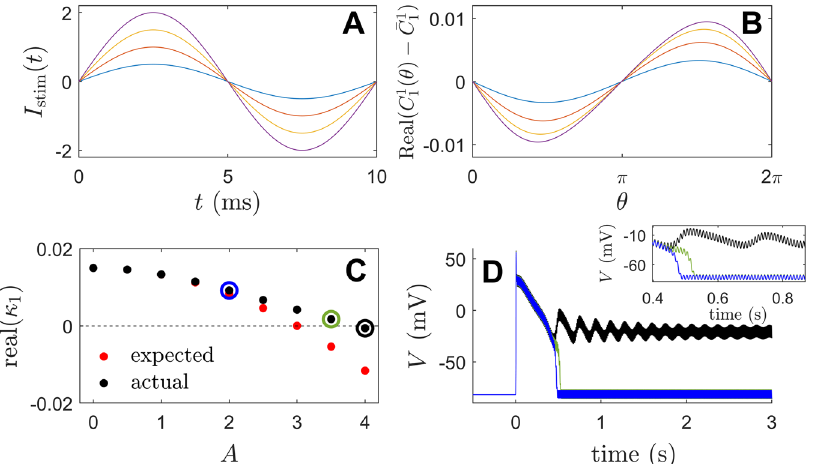
Figure 6. For the simplified 14-variable version of (13), panel A shows the magnitude of the applied stimulus. Plots in panel B of corresponding color show the real component of the mean-subtracted value of C ( ) 11 θ for the periodic orbit induced by the external stimulus. Panel C shows the actual value of the principle Floquet exponent (black dots) and the expected values (red dots) based on the relationship (3). Colored circles correspond to voltage traces from Panel D with corresponding stimulation